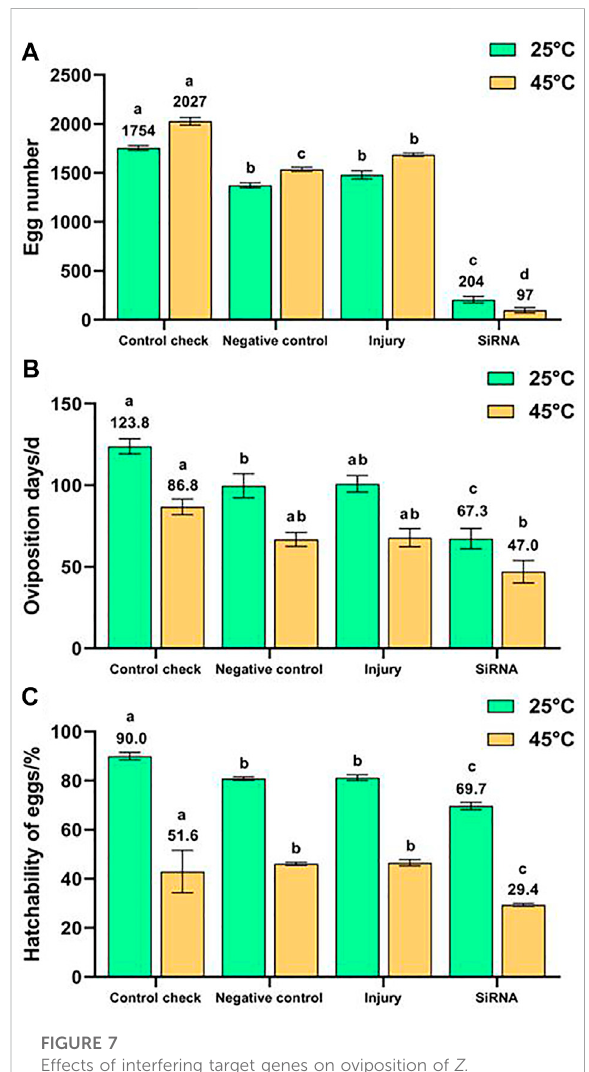
FIGURE 7 Effects of interfering target genes on oviposition of Z. cucurbitae (Coquillett). (A) Egg number (25 ° C, F = 447.038, p = 0.0001; 45 ° C, F = 1,084.647, p = 0.0001). (B) Oviposition days (25 ° C, F = 15.341, p = 0.0001; 45 ° C, F = 8.163, p = 0.0011). (C) Hatchability of eggs (25 ° C, F = 42.001, p = 0.0001; 45 ° C, F = 123.341, p = 0.0001). All values in the fi gure are presented as mean ± standard error. The letters above the bars indicate the signi fi cant difference ( p ≤